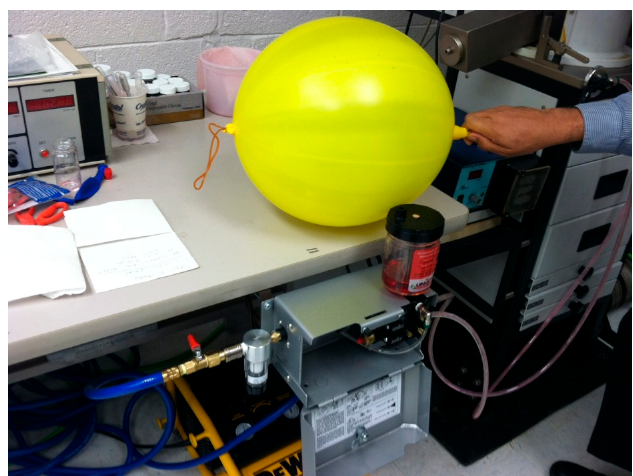
Figure 1. Balloon method for measuring the air flow rate from the mist pump.